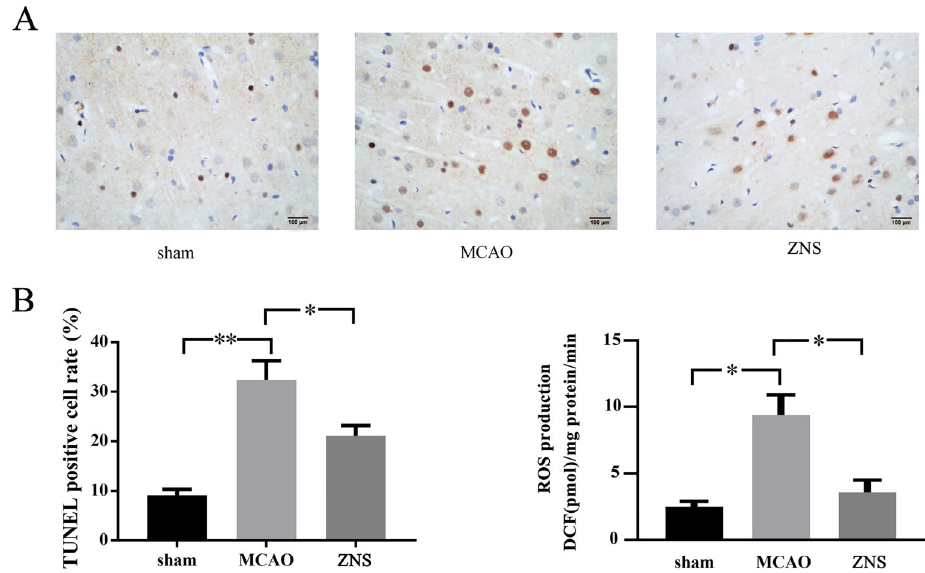
Figure 4. Treatment with zonisamide (ZNS) inhibits apoptosis of neuronal cells and reactive oxygen species (ROS) production in the penumbra of middle cerebral artery occlusion (MCAO) mice. A , Representative images of TUNEL staining (400 (cid:3) , scale bar: 100 m m). B , Mice with ZNS treatment showed fewer TUNEL-positive cells in the brain slices and lower reactive oxygen species (ROS) levels, measured in DCF fl uorescence, than the group without ZNS treatment. ZNS: middle cerebral artery occlusion surgery + ZNS treatment; sham: sham surgery. The data are reported as means ± SE (*P o 0.05, **P o 0.01 one-way